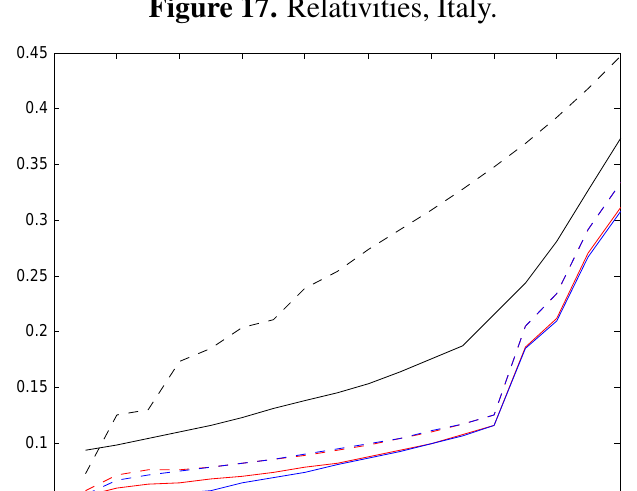
Figure 17. Relativities,